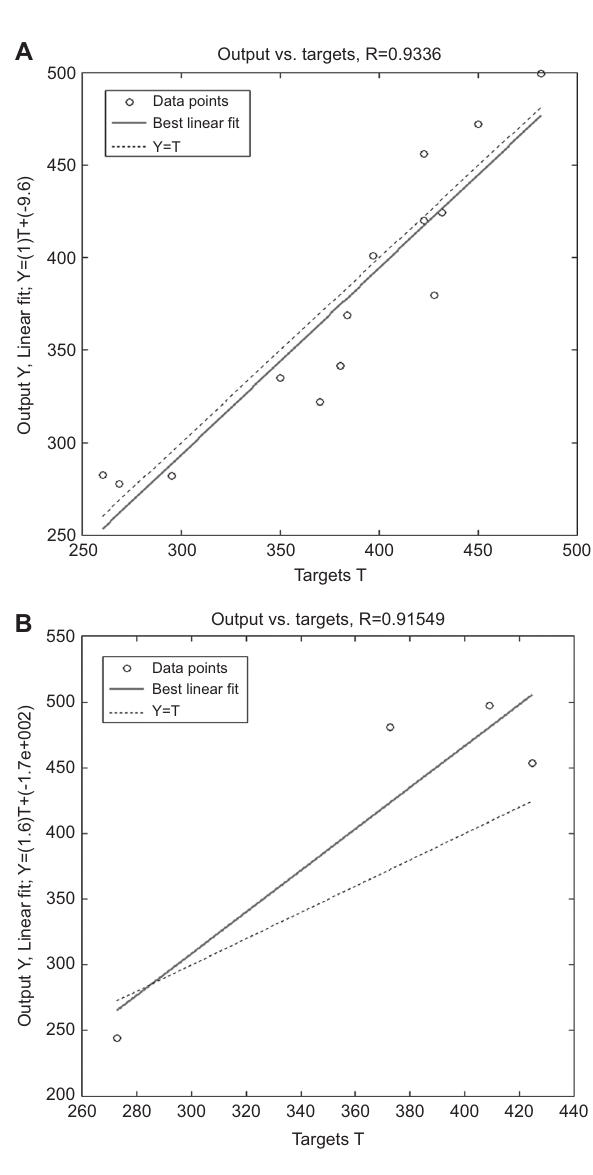
Figure 5 Correlation coefficient plot for TiO cle size response: (A) training samples, (B) validation samples.